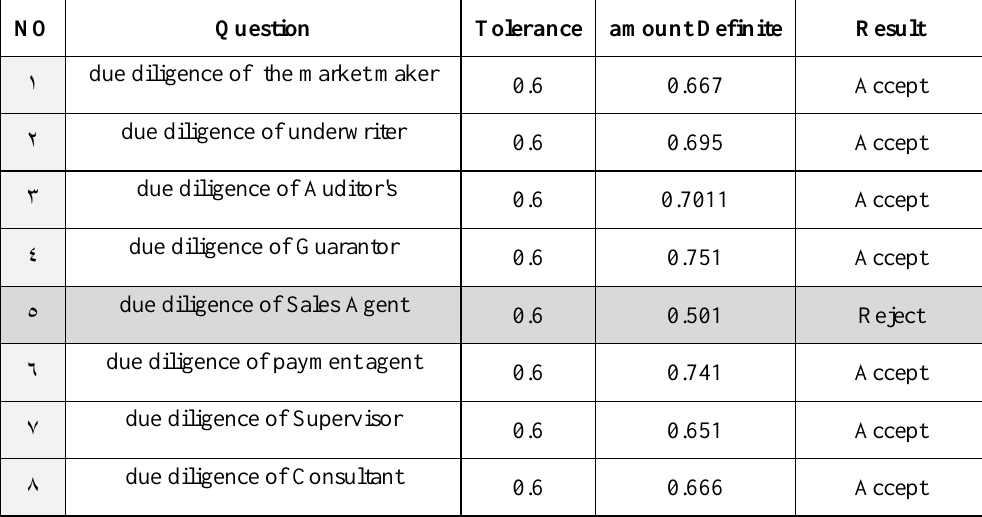
Table 2. Delphi second round